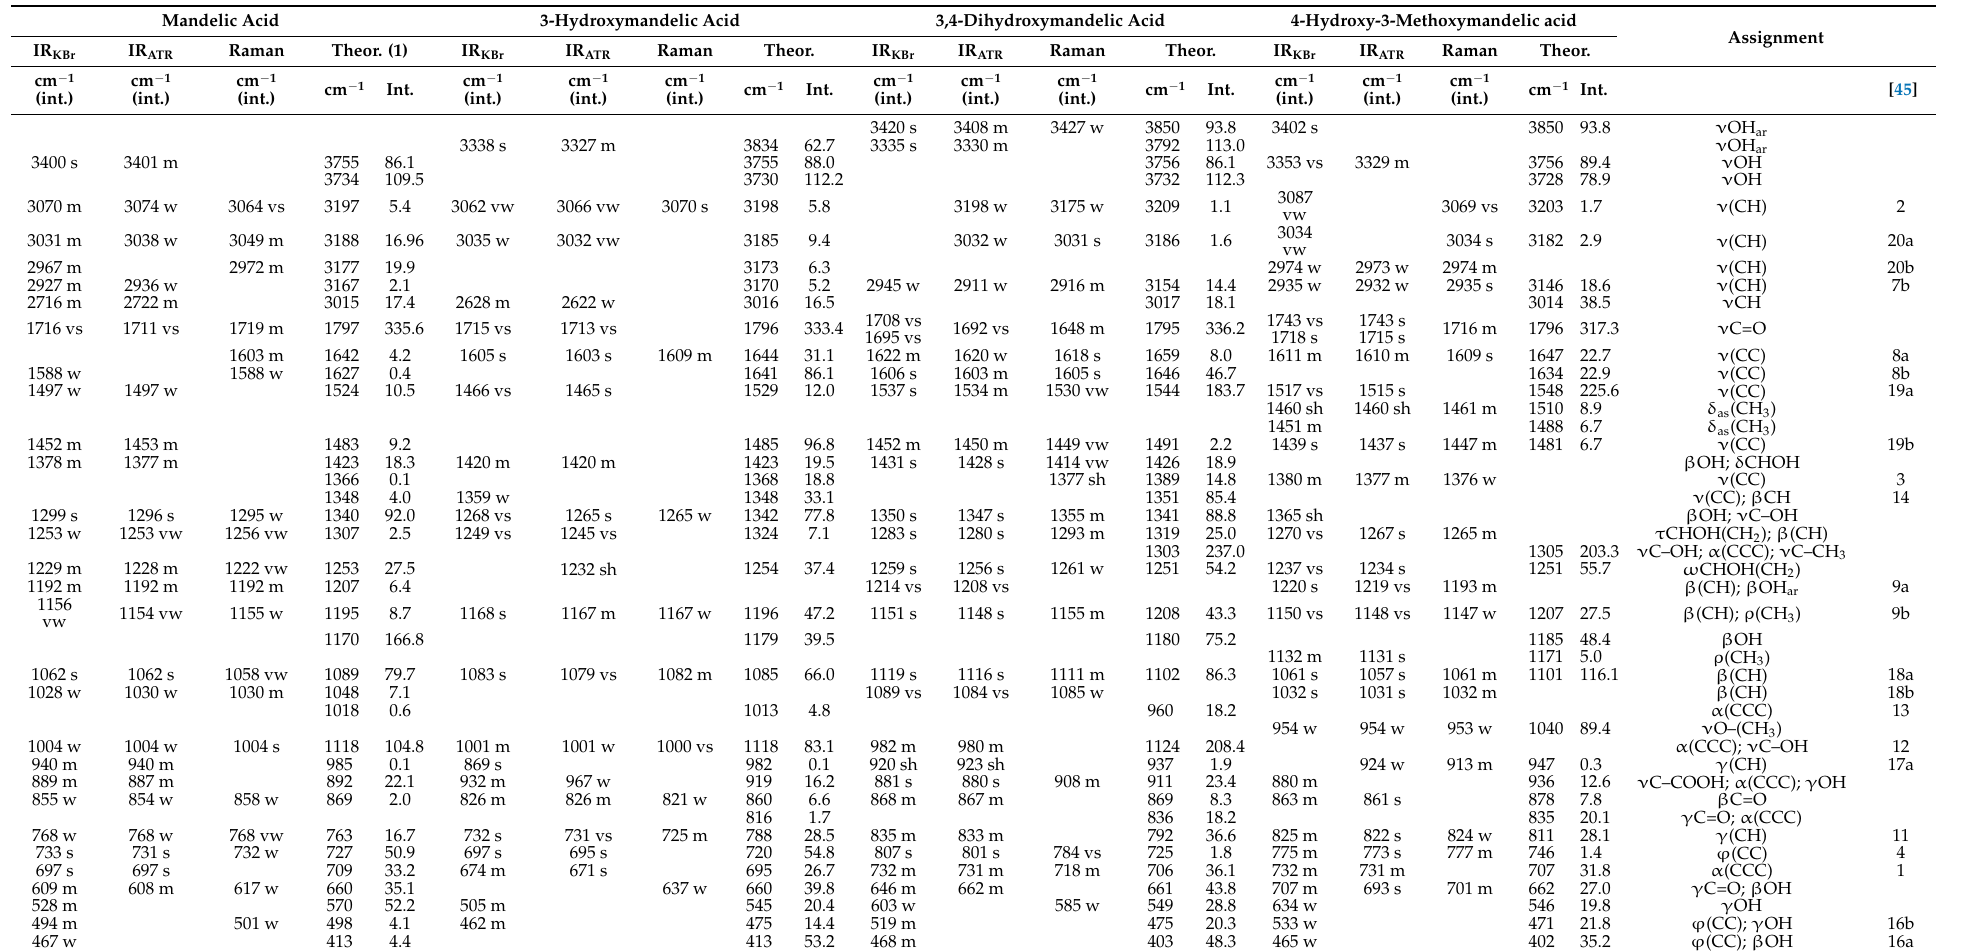
Table 6. Wavenumbers and intensities of selected bands in mandelic acid and its derivatives